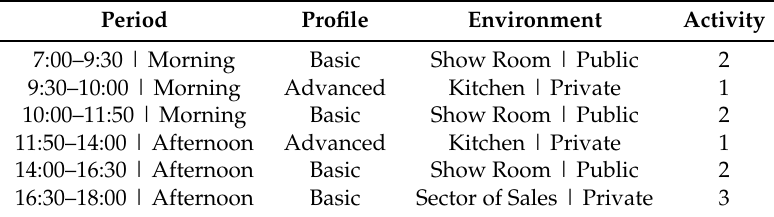
Table 12. Employee user data.